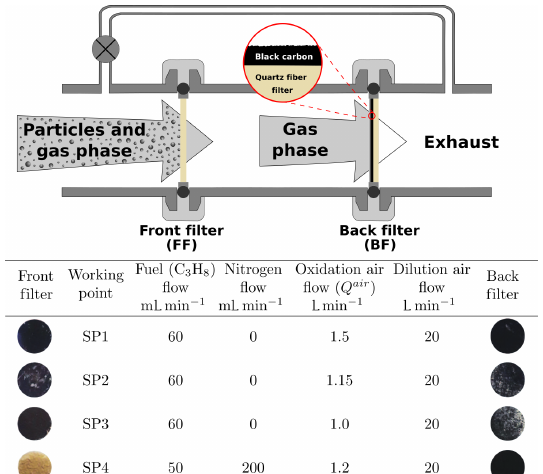
Figure 1. Schematic of the sampling line and photos of collected samples. The combustion parameters for the miniCAST burner are presented in the